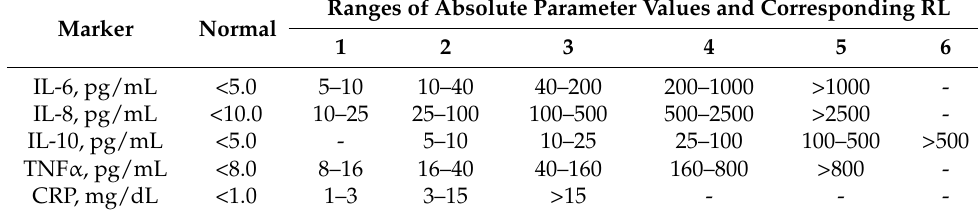
Table 4. The ranges of biomarker concentrations and their corresponding RLs.